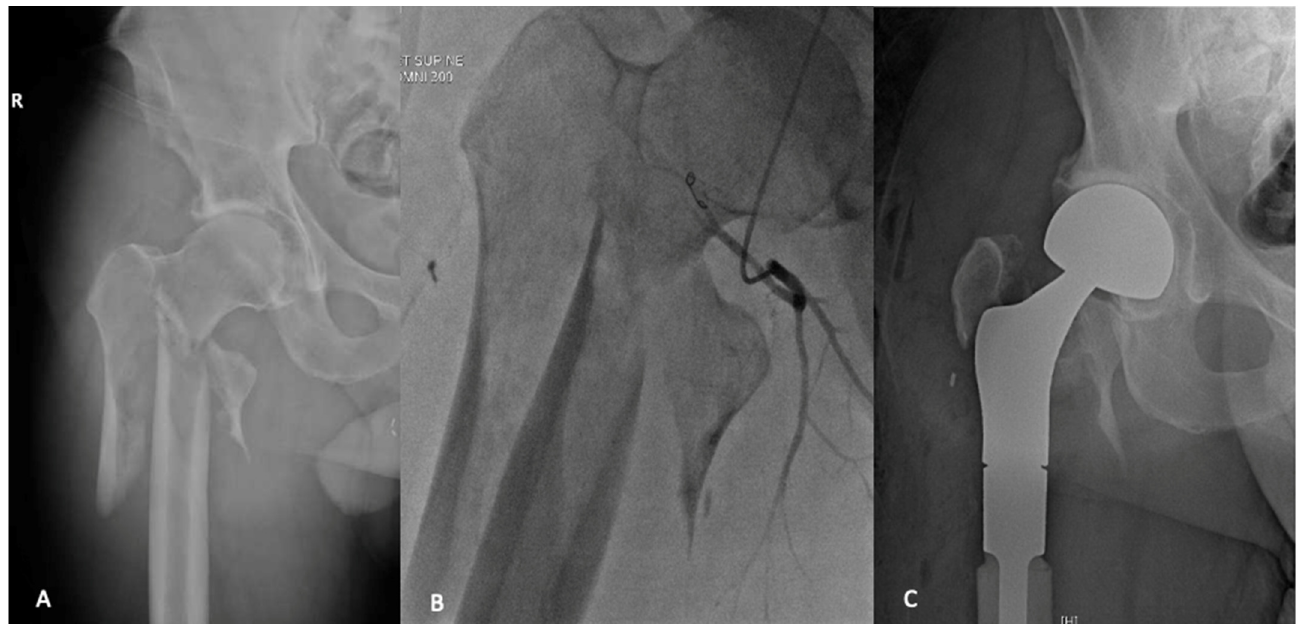
Figure 2. A 49-year-old male who presented with a pathologic fracture through an extensive lytic lesion in the pertrochanteric and subtrochanteric region ( A ). Staging and workup found this to be an isolated renal cell carcinoma metastases. Preoperative angio-embolization was undertaken ( B ), and the metastatic deposit was treated with en-bloc resection and reconstruction with proximal femoral replacement ( C ).